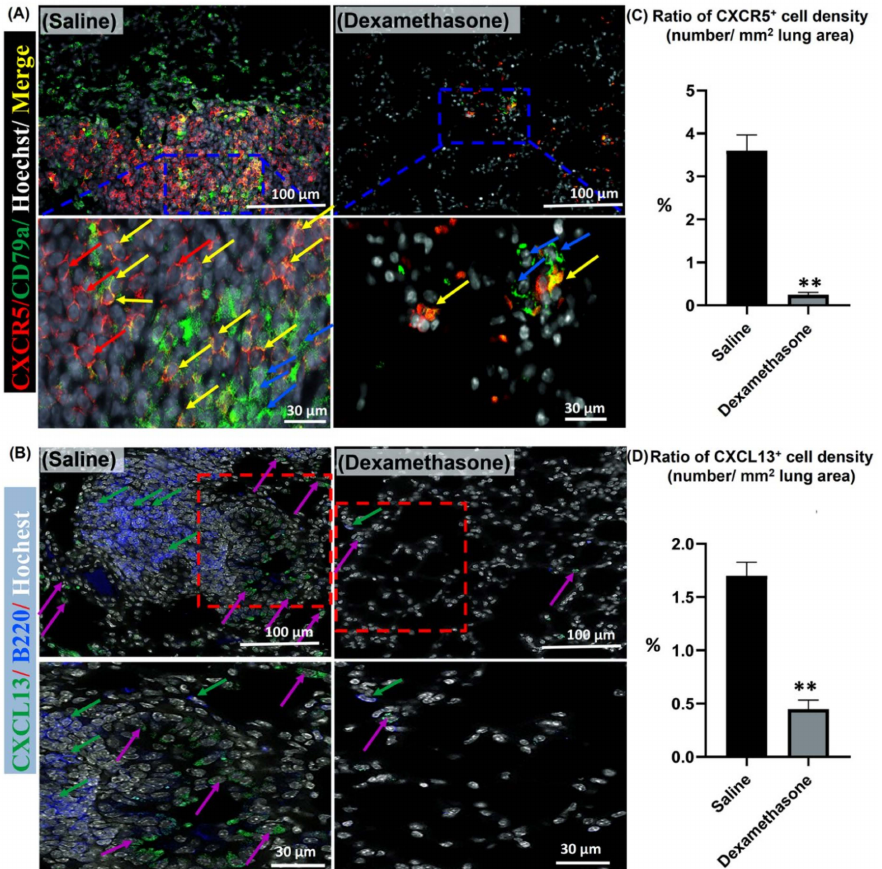
Figure 6. Analysis of the effect of dexamethasone on the expression of chemokine in the lungs of female Lpr mice. ( A , B ) Representative merged images of double immunofluorescent staining for CXCR5 “red” and CD79a “green” positive cells, and Hoechst nuclear staining “blue” ( A ) along with CXCL13 “green” and B220 “blue” positive cells, and Hoechst nuclear staining “white” ( B ). Notice positive reactions for CXCR5 (red arrows), B-lymphocytes (blue arrows), CXCL13 (violet arrows), and CXCR5 +/ CD79a + co-stained cells (yellow arrows). ( C , D ) Representative graphs showing the percentage for the ratio of positive cell density for the CXCR5 ( C ) and CXCL13 chemokines ( D ). A highly significant value (**) was observed between saline and dexamethasone groups ( p values < 0.01), where n = 5 in each experimental group. Analysis was conducted using the Mann–Whitney U test. Data are presented as mean values ±